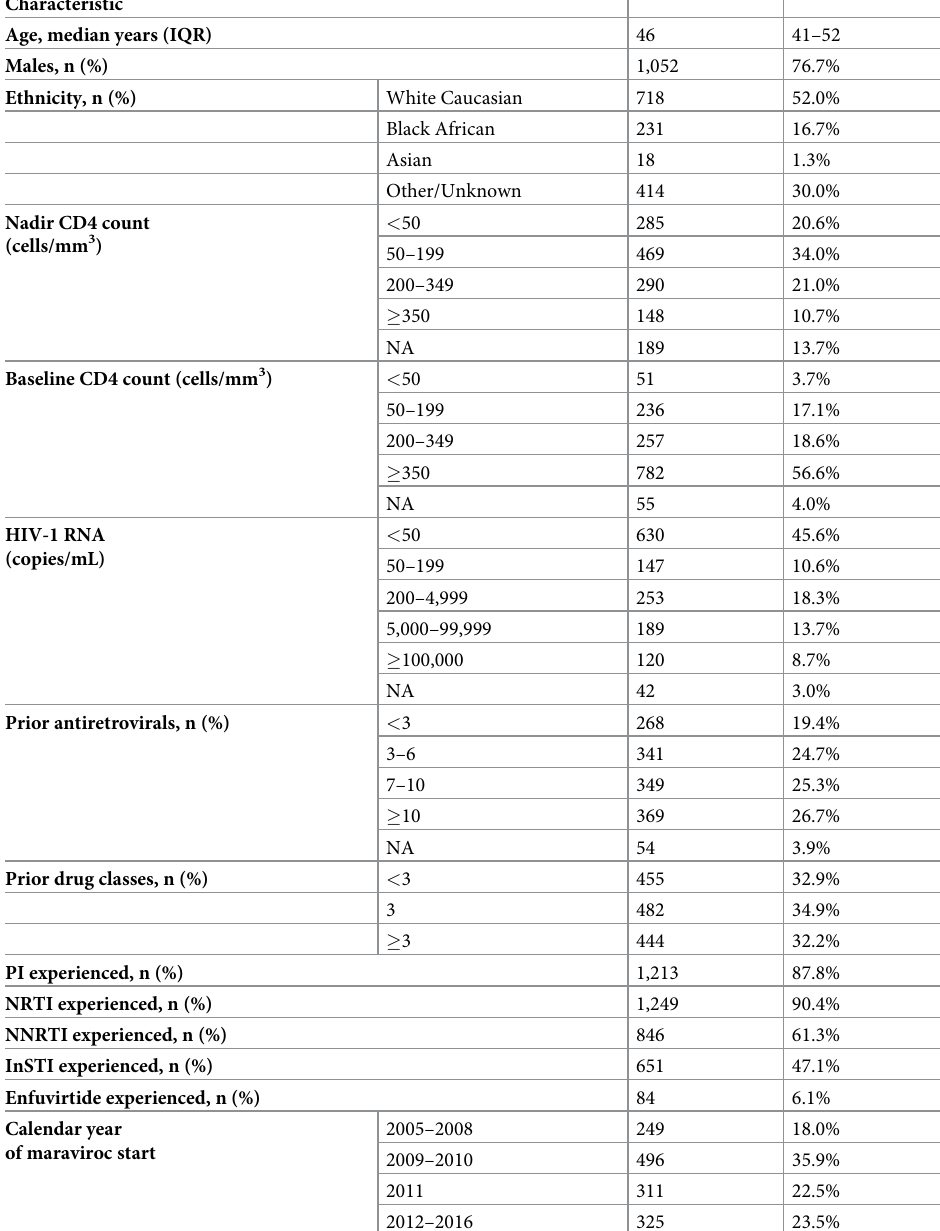
Table 1. Characteristics of the study population at the start of maraviroc (n = 1,381). Characteristic